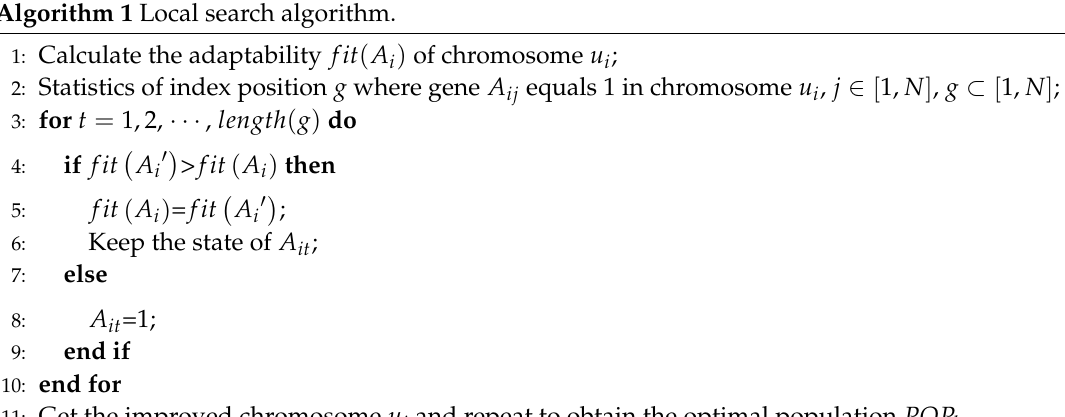
Algorithm 1 Local search